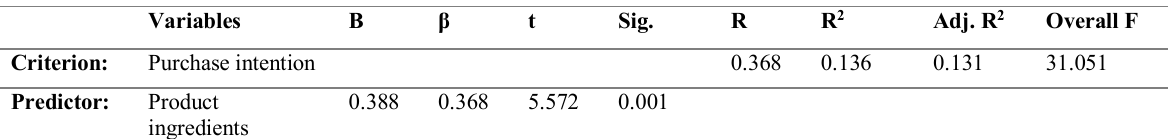
Table 8: Stepwise multiple regression for